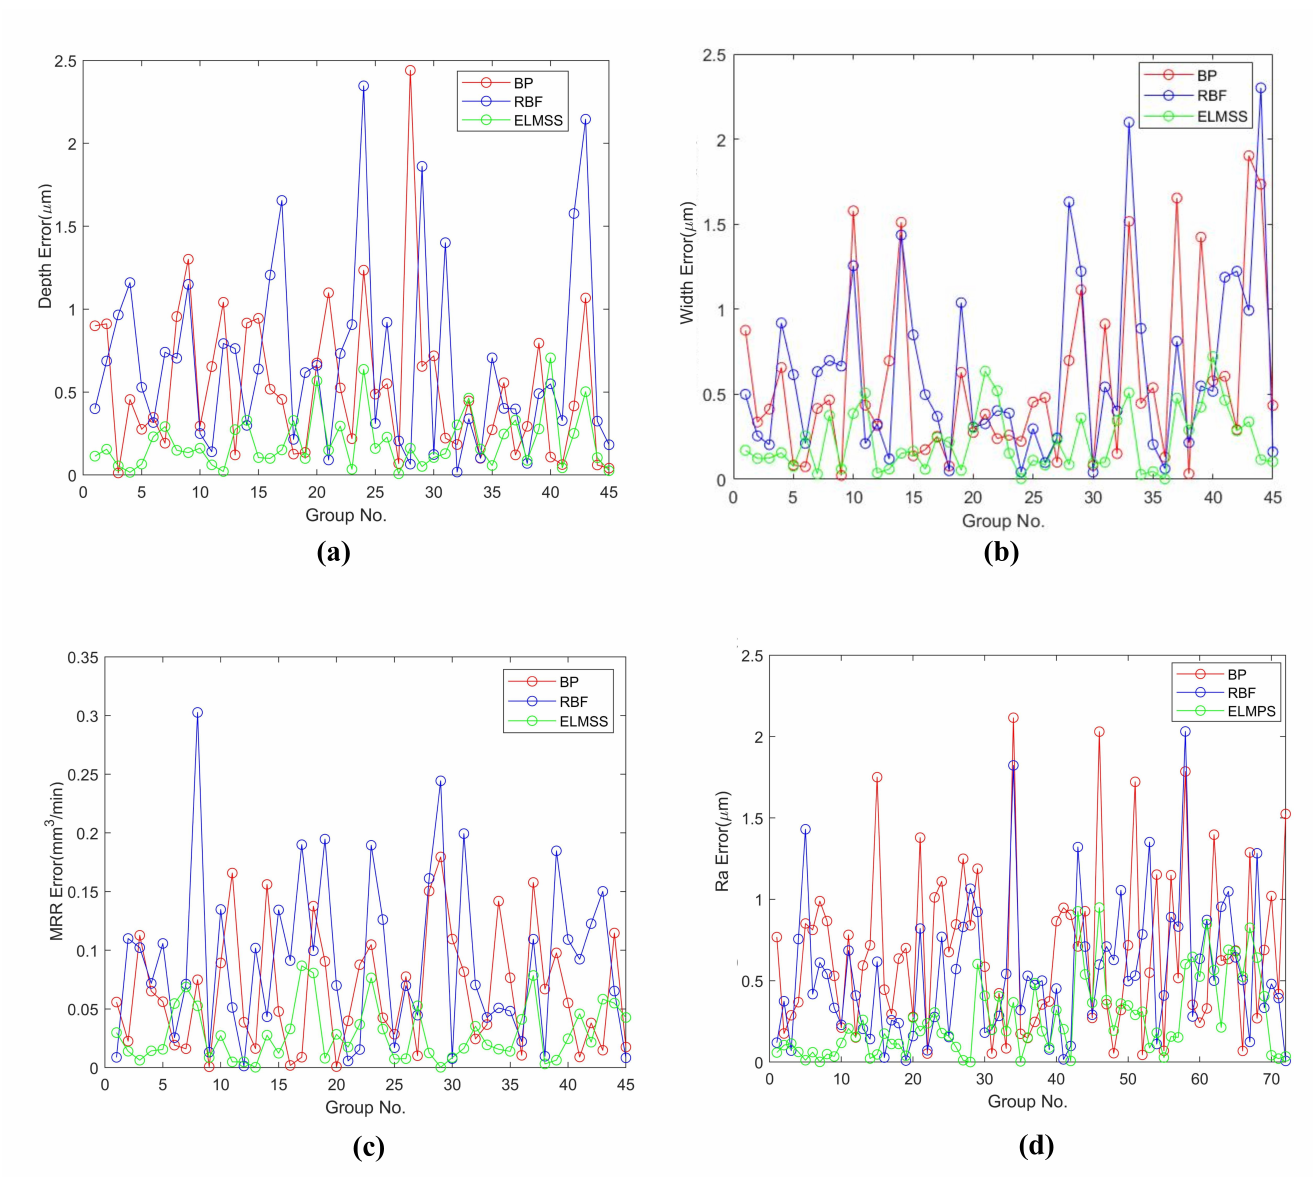
Figure 7. Absolute error between the predicted value and actual value of the three types of models. ( a ) Absolute error of D of three types of models. ( b ) Absolute error of W of three types of models. ( c ) Absolute error of MRR of three types of models. ( d ) Absolute error of Ra of three types of models. Table 7. Training time of the three types of